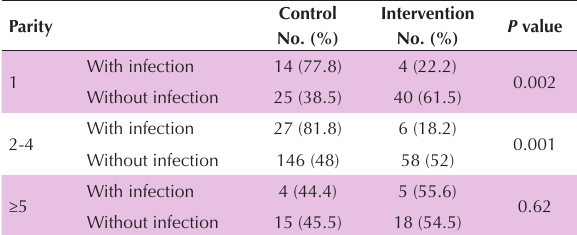
Table 4. Incidence of cesarean section infection by type of incision Incision type